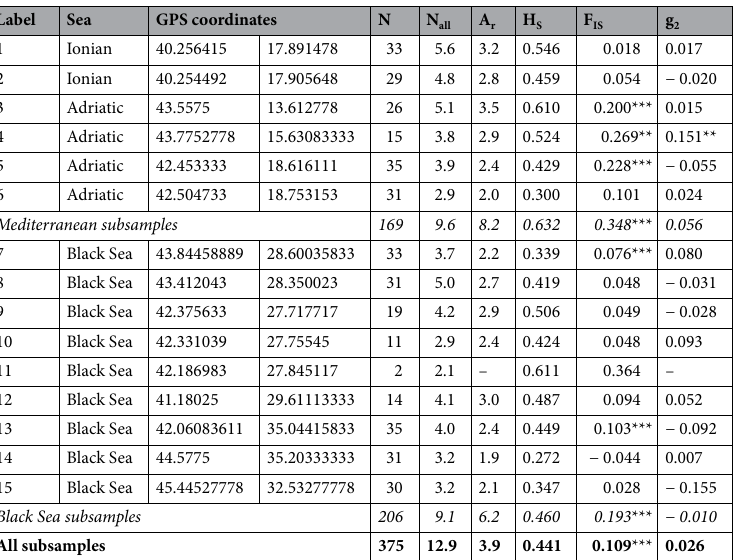
Table 1. Genetic diversity indices of the 15 sampled sites using nine microsatellite markers. Results for all Mediterranean subsamples on the one hand, and Black Seas subsamples on the other hand, are in italics. Results for all subsamples are in bold. N: number of biallelic individuals successfully genotyped, N all : mean number of alleles per locus, A r : allelic richness based on minimum sample size of 5 diploid individuals, removing sample 11, H S : gene diversity, F IS : fixation index, g 2 : estimate of the identity disequilibrium. * P -values from U test for heterozygote deficiency and for g 2 = 0 < 0.05, ** p -values < 0.01 and *** p -values <